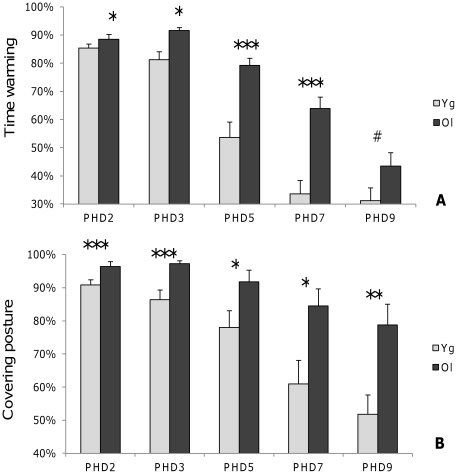
Warming and covering posture rates.Time spent warming (A) and time spent warming in covering posture (B) for the five maternal behaviour observation days (mean ± SE percentage). Mann-Whitney U-test #0.1>p,*: 0.05>p, **: 0.01>p, ***: p<0.001.